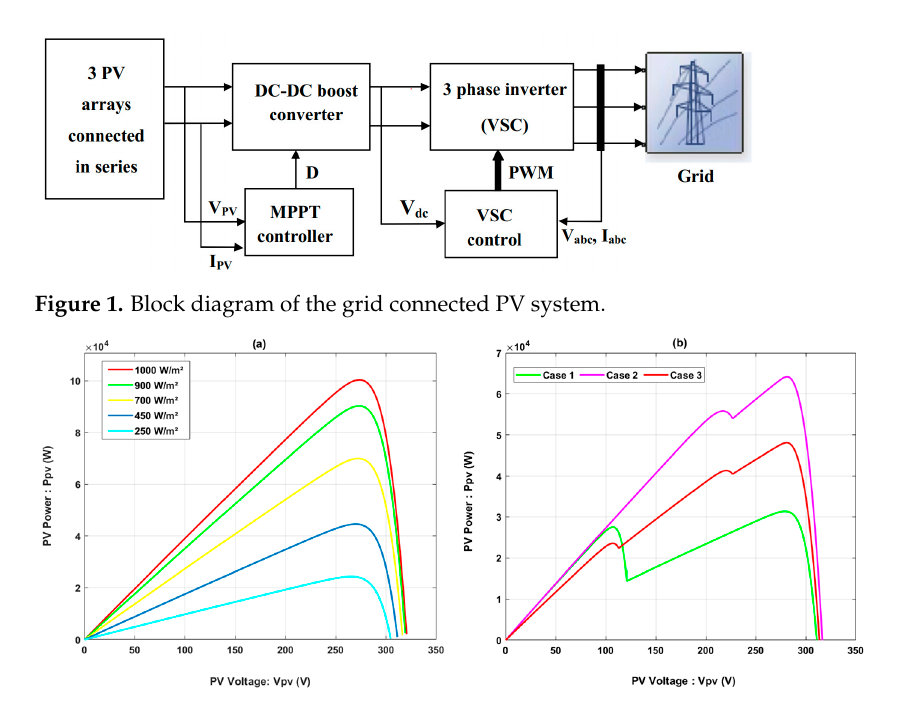
Figure 2. PV characteristic curves ( a ) under uniform solar irradiance and ( b ) under PSC.